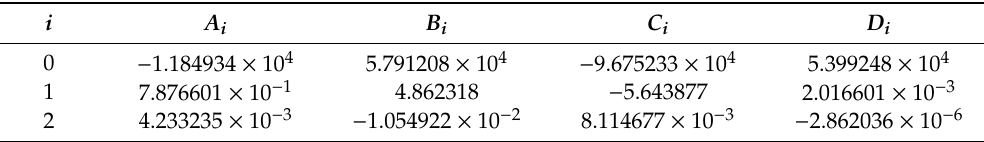
Table A12. Values of A i , B i , C i , and D i for specific